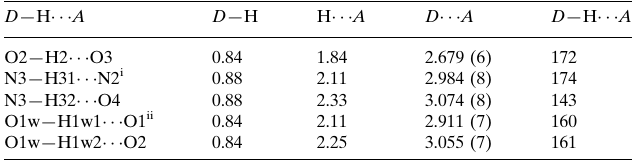
Hydrogen-bond geometry (A˚ , (cid:2)